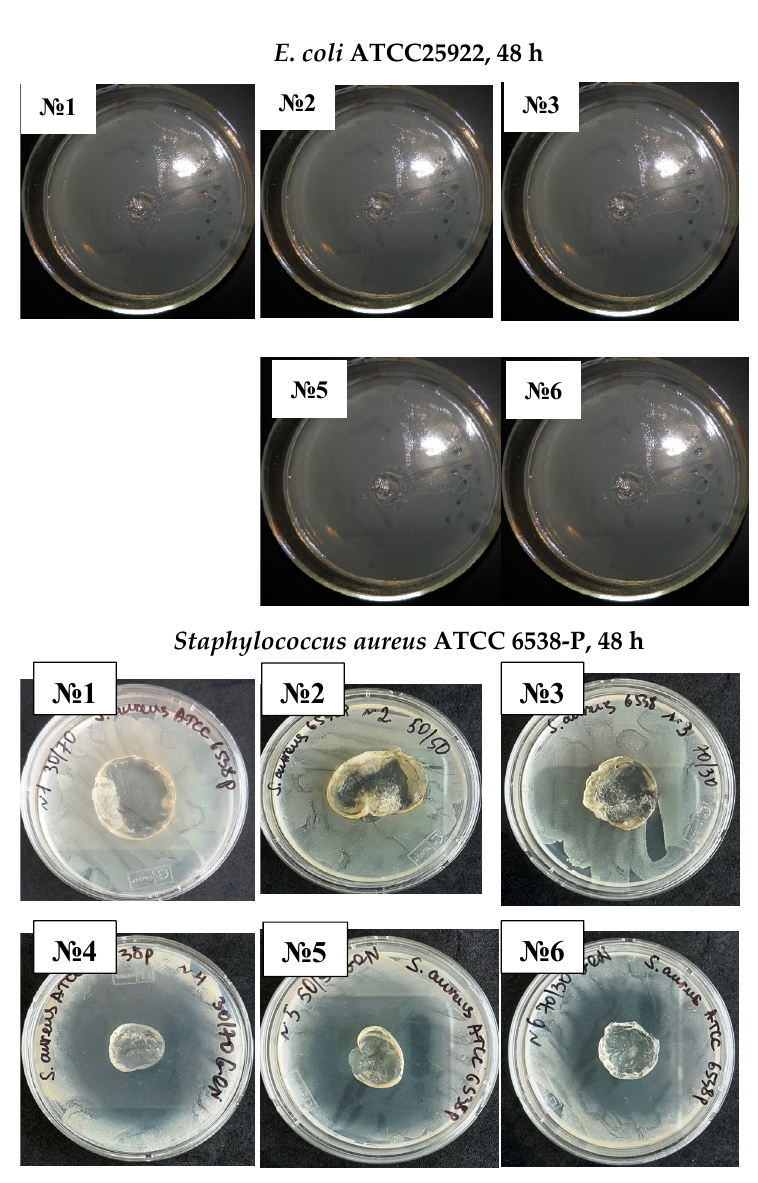
Figure 8. Antimicrobial activity of antibiotic-free and antibiotic-loaded poly(DMA-co-AAc) hydrogels against GP and GN bacteria ( № 1, 2, 3 for M1, M3, M5; № 4, 5, 6 for M 1, M3, M5 with